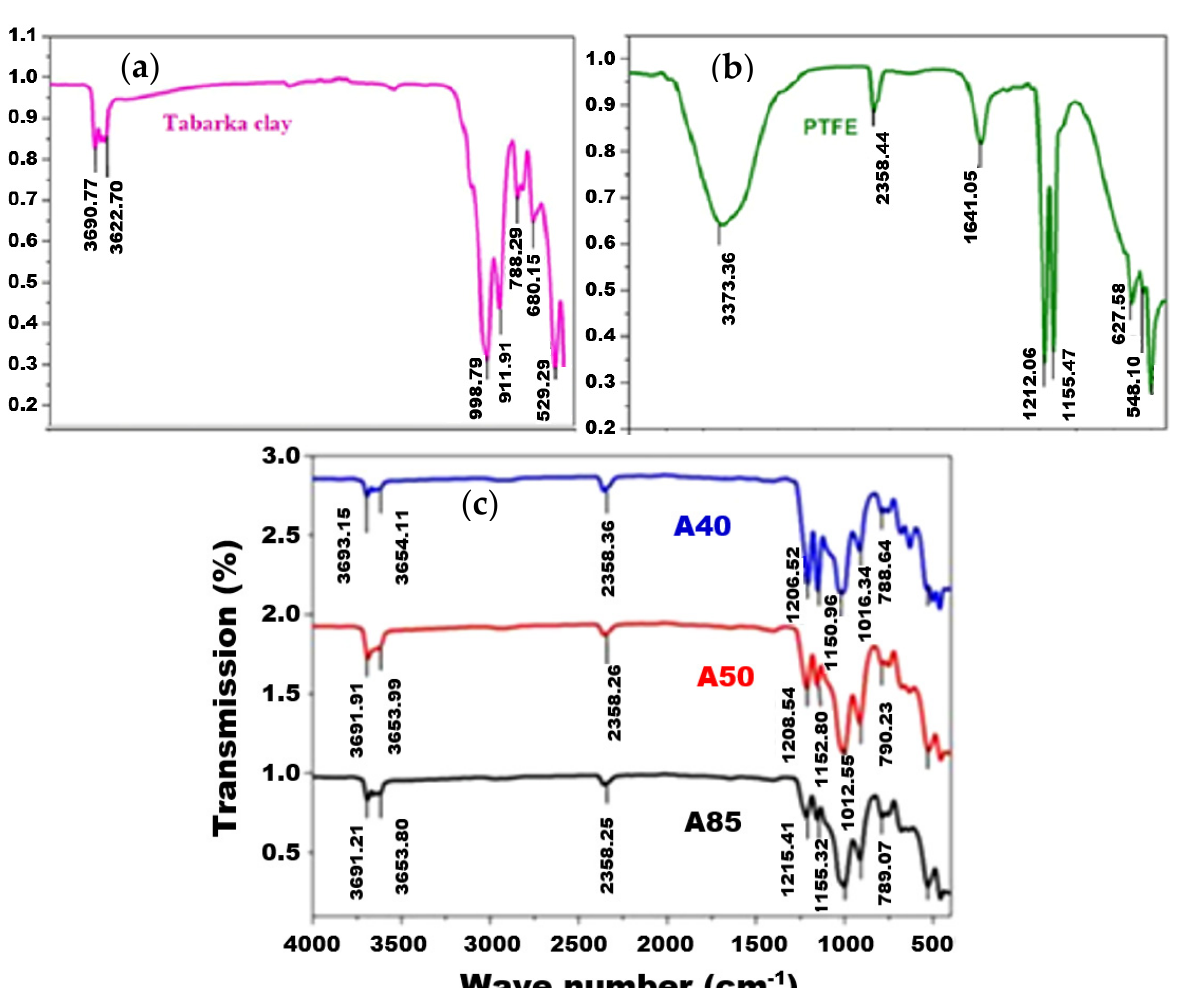
Figure 4. FTIR spectrum of pure clay ( a ), pure PTFE ( b ), and composite A40, A50, and A85 membranes ( c ). The comparison of the FTIR spectra of the pure PTFE, the clay, and the composite membranes (A85, A50, and A40) suggests that the characteristic bands of PTFE and clay are present in the different prepared membranes. Indeed, for membrane A50, for example, both bands located at 12,028.54 and 1152.80 cm − 1 mark the presence of CF 2 . The band that appeared at 1012.55 cm − 1 is assigned to the bond vibration of Si-O, and the